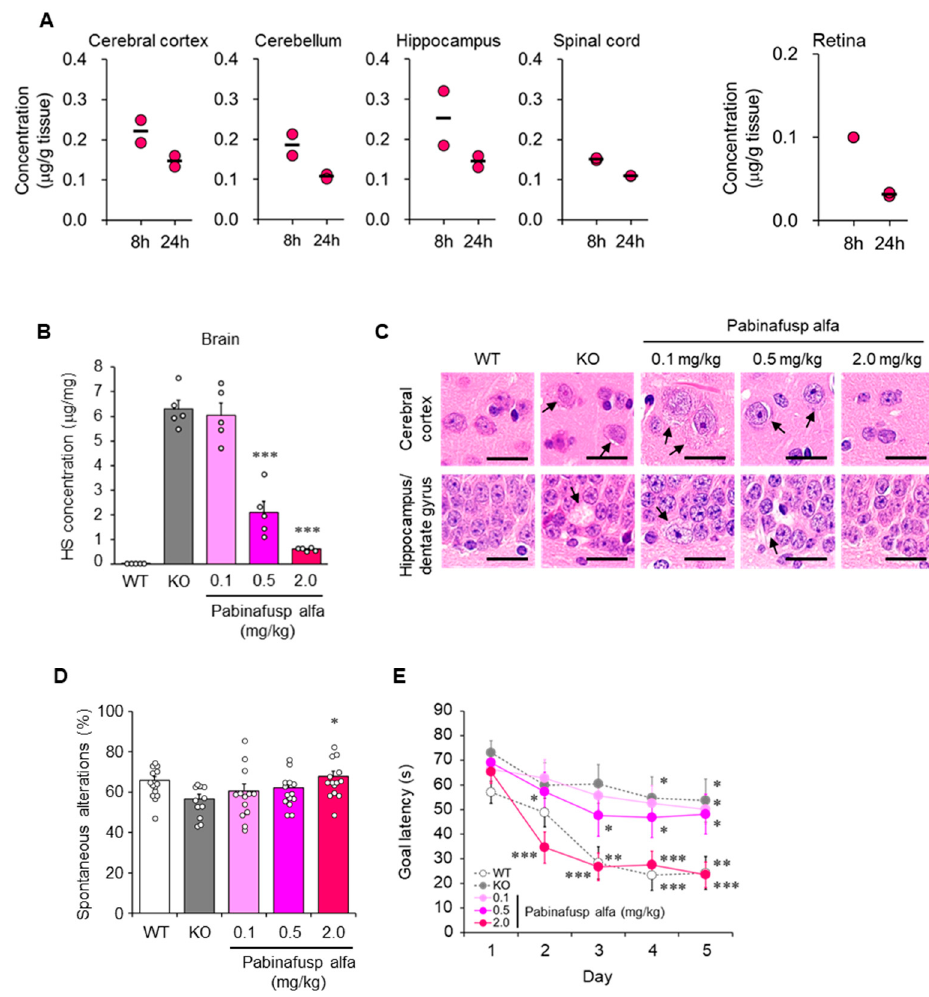
Figure 3. Central nervous system (CNS) distribution and efficacy of pabinafusp alfa. ( A ) CNS distribution of pabinafusp alfa in cynomolgus monkeys after a single intravenous administration at 5 mg/kg. Individual values are plotted. Bars indicate the mean. Except for retina data, the graphs were reproduced from the article by Sonoda et al. [105]. Copyright© 2018 licensed under Creative Commons Attribution License (CC BY-NC-ND 4.0). ( B – E ) Heparan sulfate (HS) concentrations in the brain, brain histopathology, and neurological function of mucopolysaccharidosis (MPS) II mice intravenously administered with pabinafusp alfa at indicated dosages for 36 weeks. ( B ) HS concentrations in the brain. Values are expressed as mean ± SEM ( n = 5). *** p < 0.001 versus KO control (Dunnett’s test). ( C ) Brain samples stained with hematoxylin and eosin. Arrows indicate vacuolation or swelling of neuronal cells. Scale bars, 20 mm. ( D ) Rate of spontaneous alterations representing the immediate working memory assessed by Y-maze test. Values are mean ± SEM ( n = 11–14). * p < 0.05 between KO and the treatment group (Dunnett’s test). ( E ) Goal latency as spatial learning ability evaluated using the Morris water maze test. Values are means ± SEM ( n = 11–15). ** p < 0.01, *** p < 0.001 versus day 1 within each group (paired t-test). WT, wild-type mice; KO, vehicle-treated MPS II mice. Reproduced from the article by Morimoto et al. [107]. Copyright©